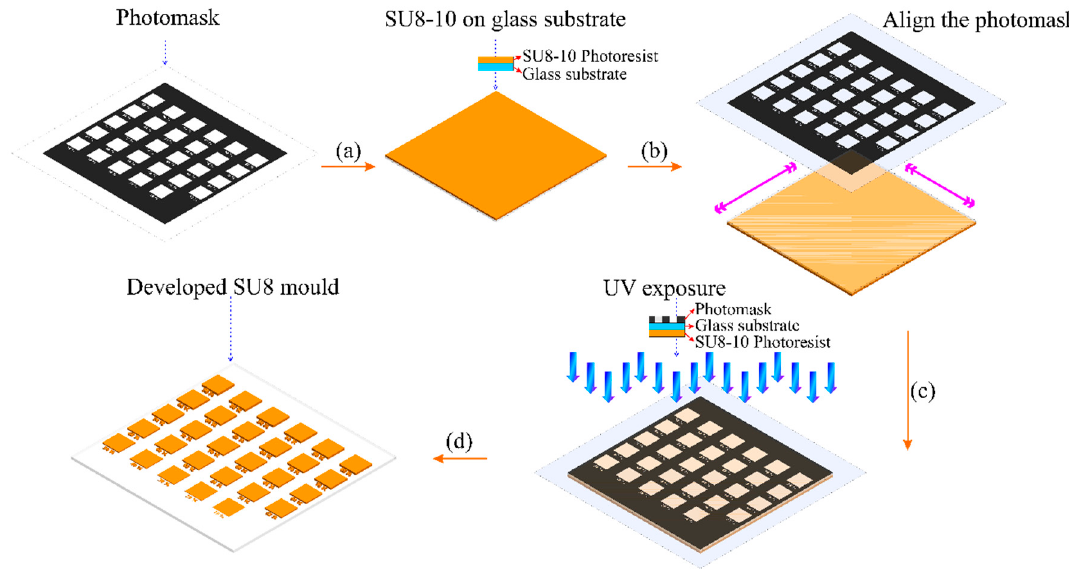
Figure 2. Grayscale photolithography process for SU8 mould development.